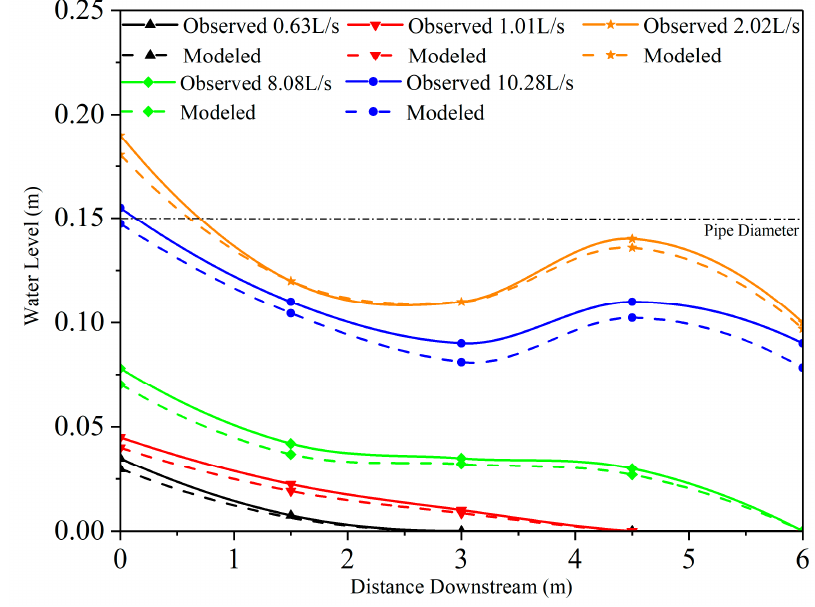
Figure 12. Comparison of the FLOW-3D model simulations with the experimental results.